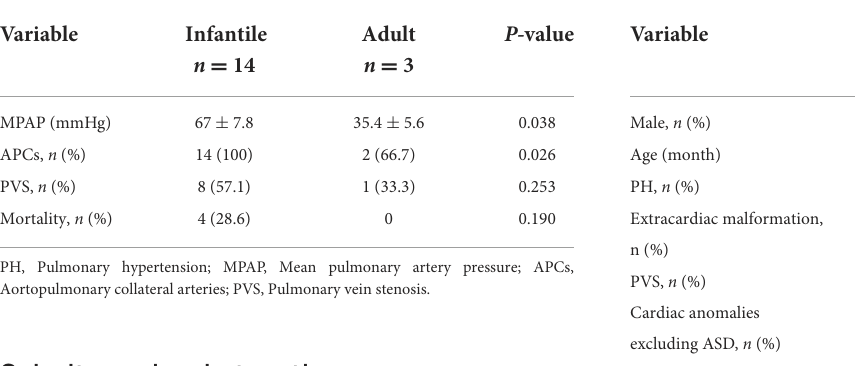
TABLE 5 Univariate analyses of risk factors for